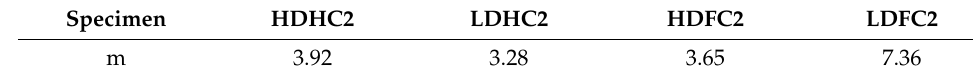
Table 7. Paris law coefficient for different sandwich specimens.